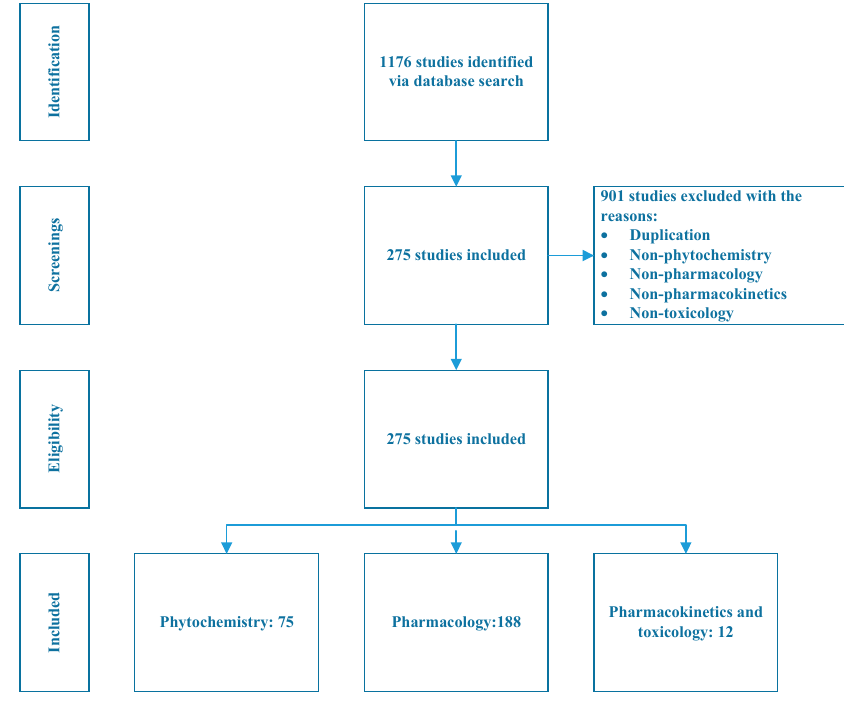
Figure 2. Study selection process for included studies related to Cnidium monnieri (L.) Cusson .